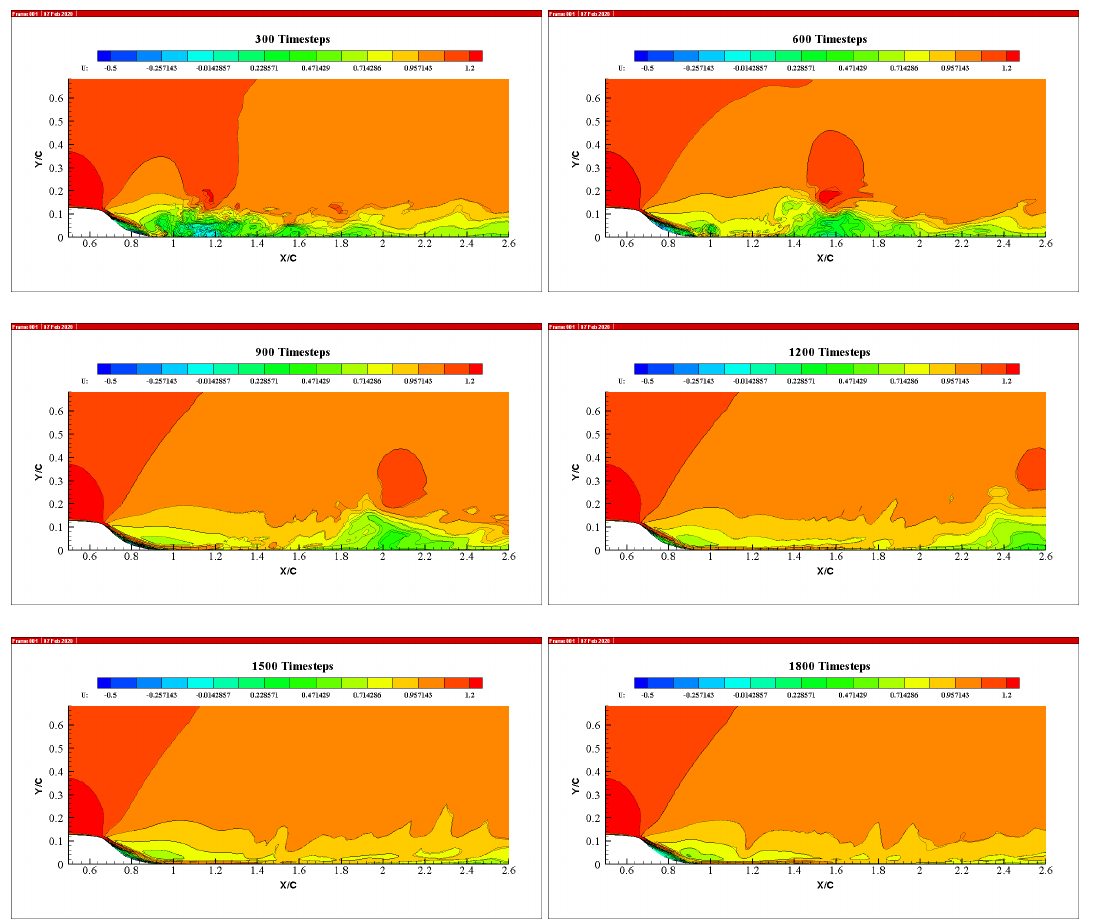
Figure 20. Plasma-induced instantaneous U-velocity at different time